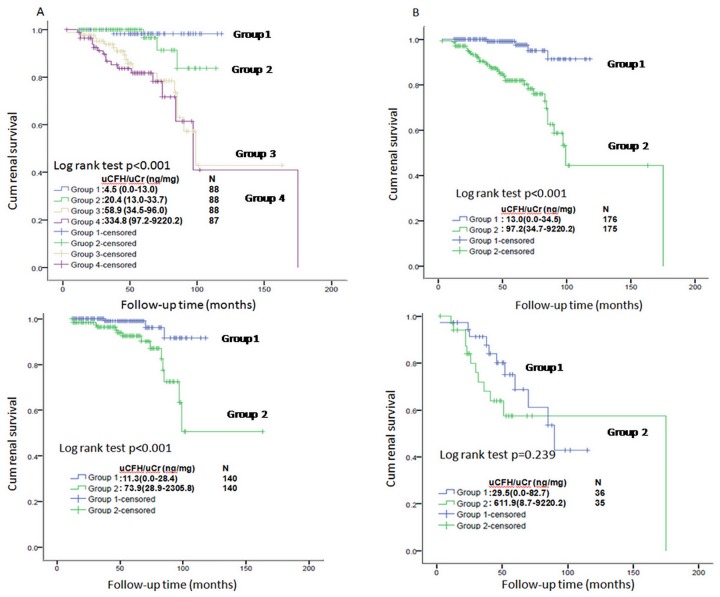
Urinary CFH levels predicted renal survival in the IgAN cohort.The survival curve was derived from Kaplan—Meier analysis and compared by log-rank test. A. Urinary CFH levels and renal survival in the whole cohort by quartiles. Patients were divided into four groups according to uCFH/uCr quartiles; the first quartiles had the lowest uCFH/uCr values (0.0–13.0ng/mg). Patients in the third and fourth quartiles had more frequently progressed to composite endpoints. B. Median urinary CFH levels and renal survival in the whole cohort. All individuals were divided into two groups by median uCFH/uCr values. The patients with higher uCFH/uCr had increased risk of progressing to the composite endpoint. C. Median urinary CFH levels and renal survival in the subgroup of patients with eGFR≥60mL/min/1.73m2. Individuals with eGFR≥60mL/min/1.73m2 were divided into two groups by median uCFH/uCr. The patients with higher uCFH/uCrhad increased risk of progress to a composite endpoint. D. Median urinary CFH levels and renal survival in the subgroup of patients with eGFR<60mL/min/1.73m2.